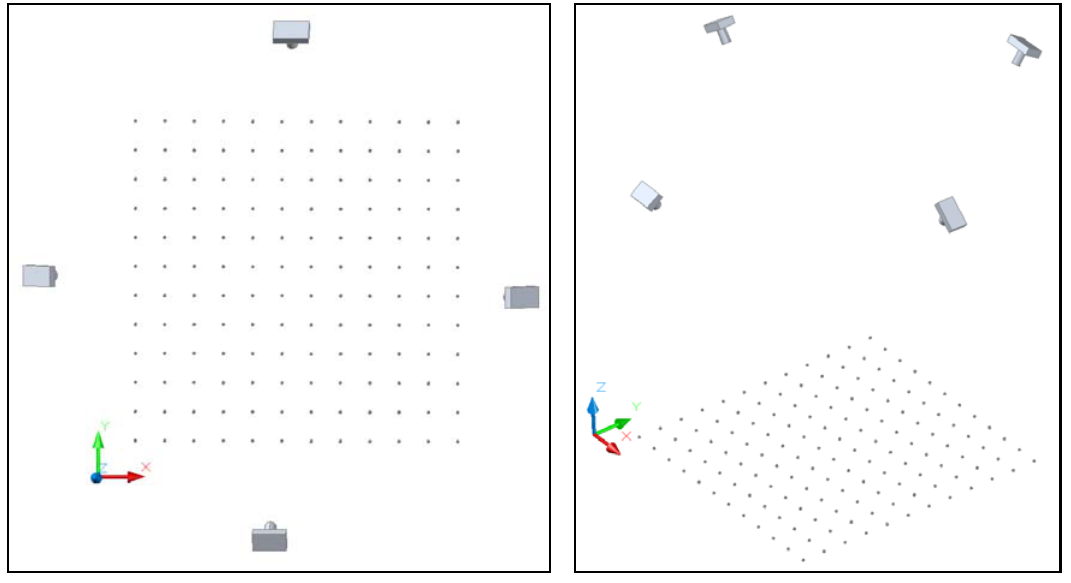
Figure 2. Network configuration of the photogrammetric